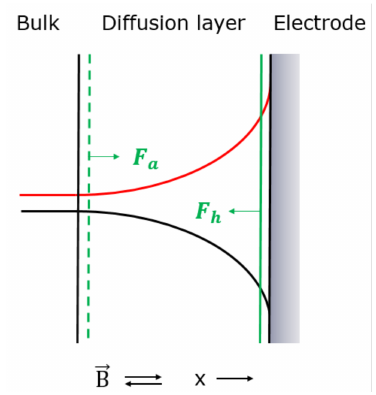
Figure 4. Illustration of concentration profile (black) [49,50] and reluctance profile (red) for deposition of the paramagnetic metal ions on an electrode surface. F a and F h (green) represents the magnetic → B , was applied perpendicular to the electrode concentration gradient force. The magnetic field, surface. Positive x -direction is